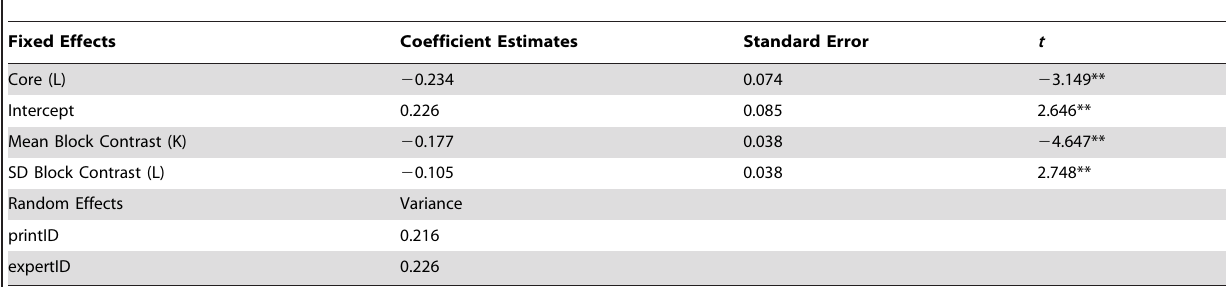
Table 3. Predictors for response time model.